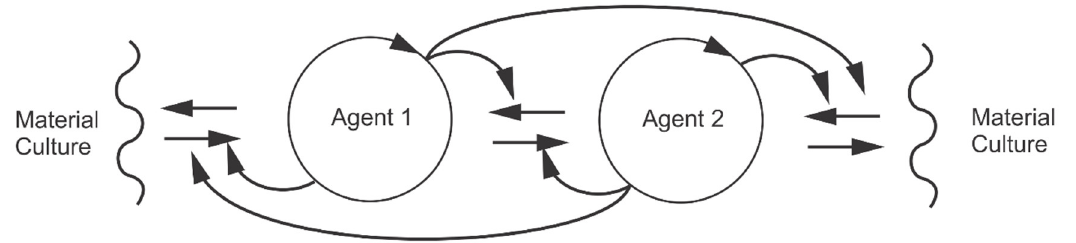
Figure 2. Coregulation of couplings in prosthetic-mediated agents and cultured material environments, based on [21].